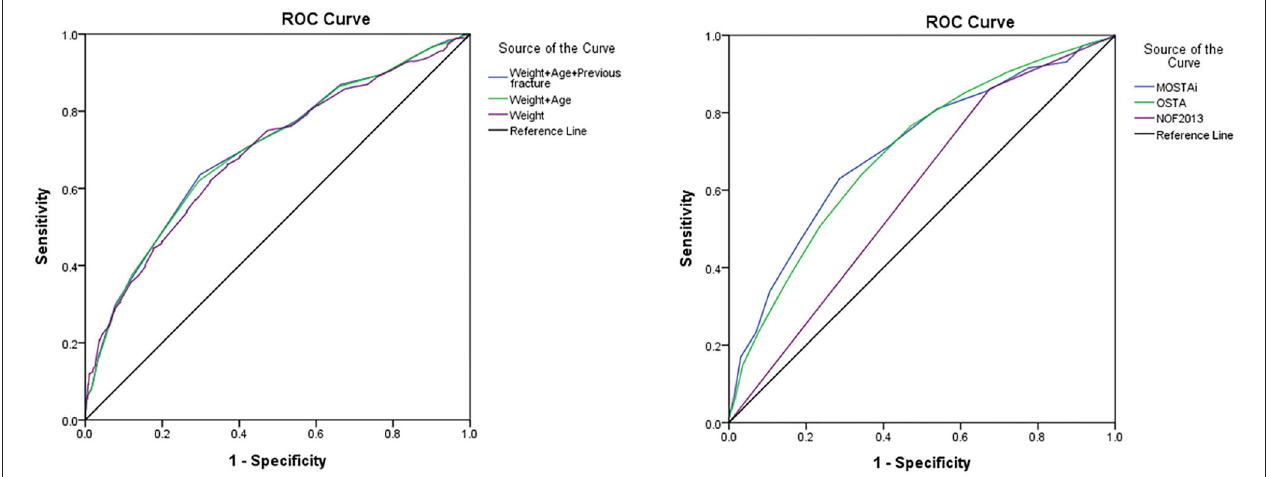
FIGURE 2 | The receiver operating characteristic (ROC) curve of the developmental cohort (left side). The ROC curves for predicting osteoporosis by MOSTAi, OSTA, and NOF 2013 (right side). OSTA, osteoporosis self-assessment tool; NOF 2013, National osteoporosis foundation recommendations in 2013; MOSTAi, modified male osteoporosis self-assessment tool for